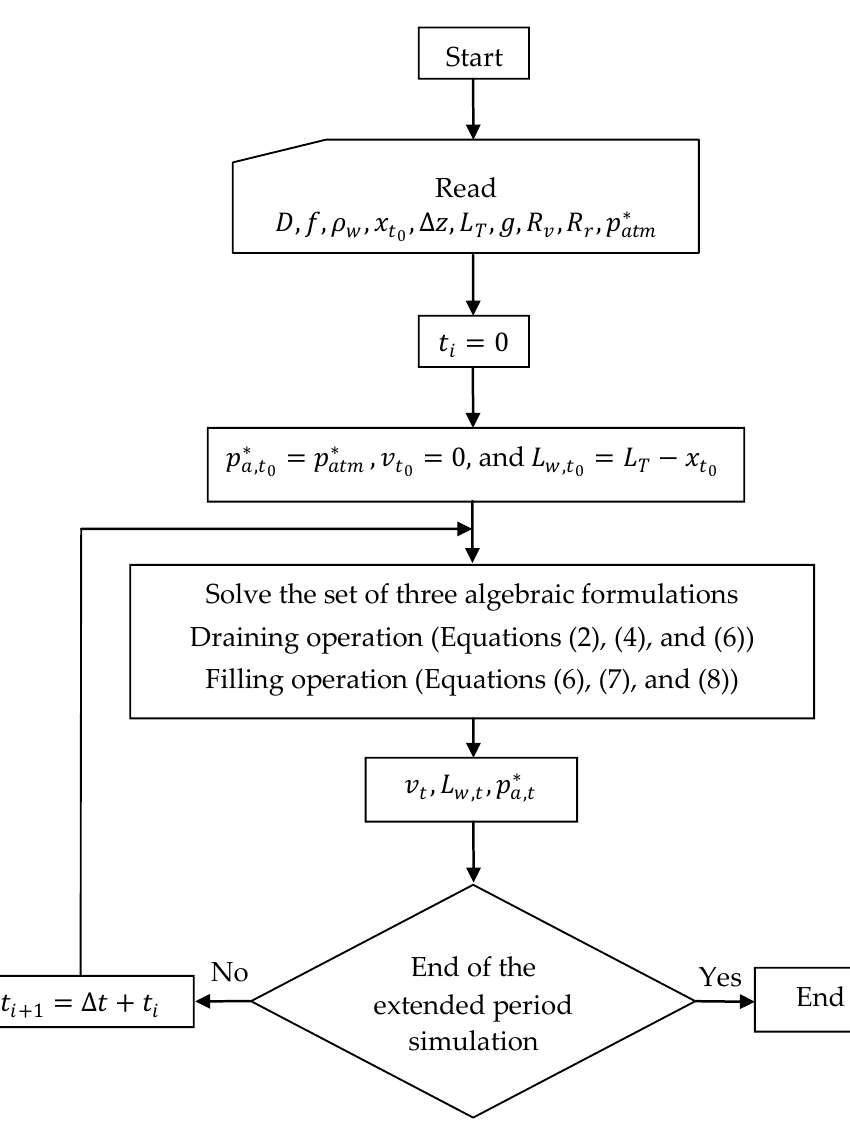
Figure 3. Flowchart of numerical resolution of a draining process using a quasi-static flow model.